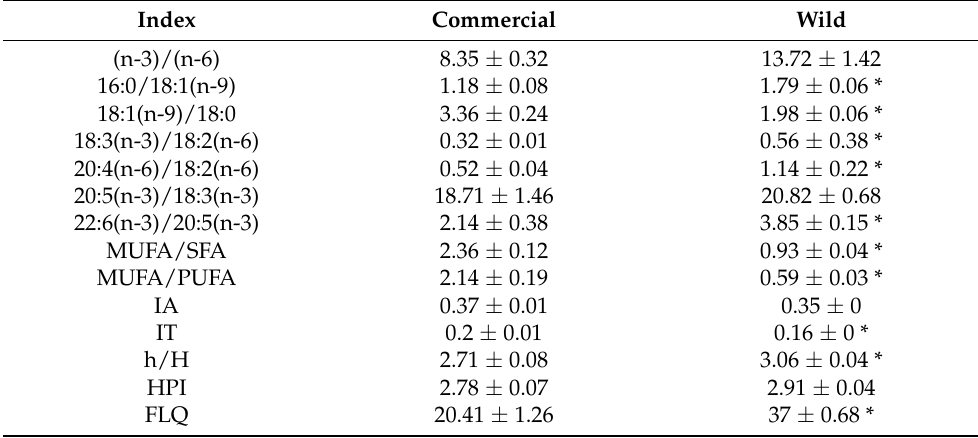
Table 1. Certain significant nutritional indexes and metabolic ratios in muscle of wild and commercial of the studied specimens of beaked redfish Sebastes mentella.